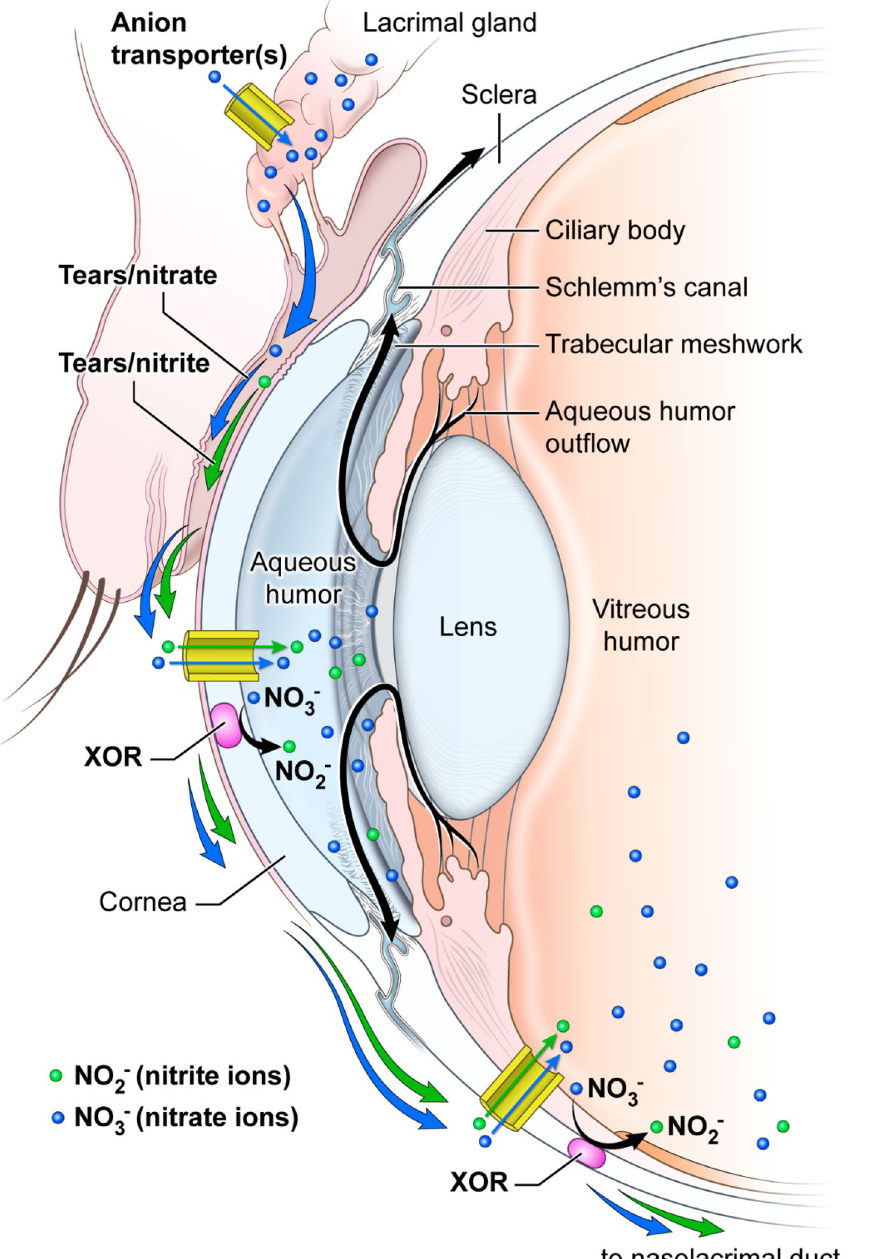
Figure 5. A diagram of the proposed major pathways for nitrate ion transport and metabolism in the anterior structures of the human eye. We present a schematic of the structure of the anterior part of the human eye with our hypotheses about possible transport of nitrate (NO 3− ) and nitrite (NO 2− ) ions and their metabolism by reductive chemistry. We postulate that the lacrimal glands act similarly to salivary glands by concentrating nitrate from the blood and secreting it into ducts which transport these ions in the tear fluids to the conjunctiva, where bacterial enzymes can reduce them to nitrite and NO. We have shown that majority of eye tissues express sialin, which is a known nitrate ion transporter, but there may be other anion transporter molecules which can also act as nitrate transporters. These processes for formation of NO in the eye are in addition to its formation from arginine by the NOS enzymes that is prevalent at normoxia that has largely been studied up until now (not shown on the diagram). Nitrate and nitrite ions can also enter the sclera and cornea where xanthine oxidoreductase (XOR) and other as yet unknown agents appear to be able to reduce them into nitrite and NO, especially under hypoxic conditions, and then diffuse into the anterior chamber of the eye. This would likely result in increased flow of intra-ocular fluids into Schlemm’s canal, as well as increased blood flow, especially in the retina. The tear fluid is also collected into the naso-lacrimal ducts which flow into the nasal cavity and may contribute to the high levels of exhaled NO from the oropharyngeal cavity. Symbols: blue small circles: nitrate ions; green small circles: nitrite ions; blue arrows: flow of nitrate ions; green arrows: flow of nitrite ions; yellow half cylinders: anion transporter membrane proteins, including